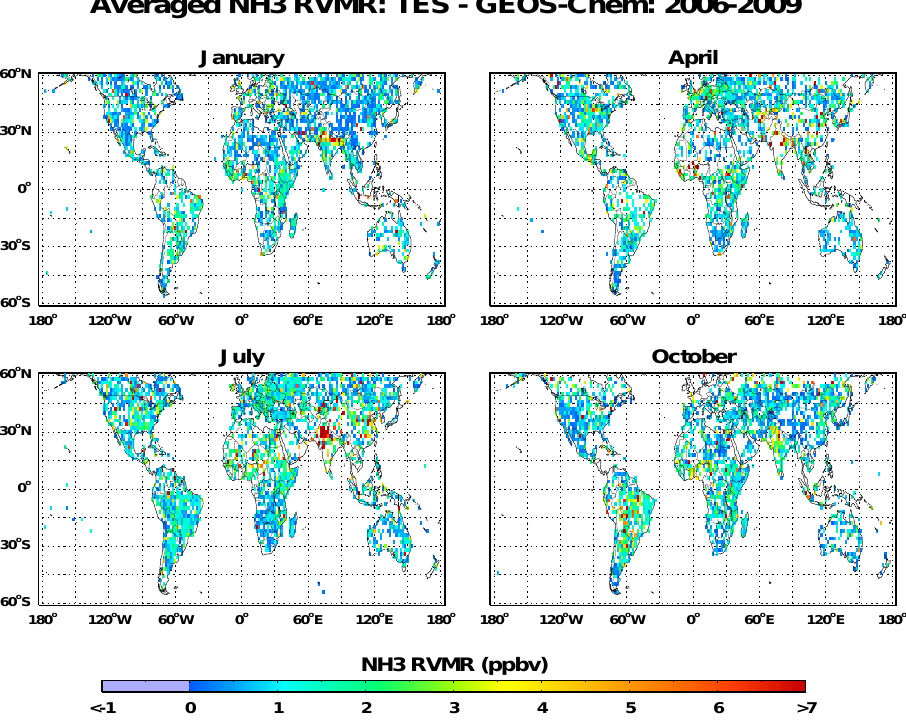
Fig. 13. Difference (TES – GEOS-Chem) RVMR plots for the 2 × 2.5 ◦ averages.